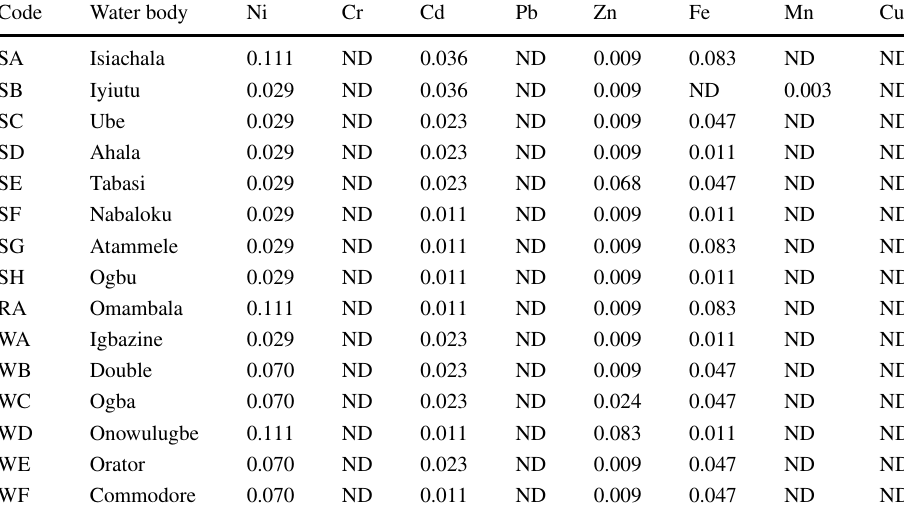
Table 4 Concentration of Heavy Metals (mg/L) in Water Samples from Ifite Ogwari ( n =